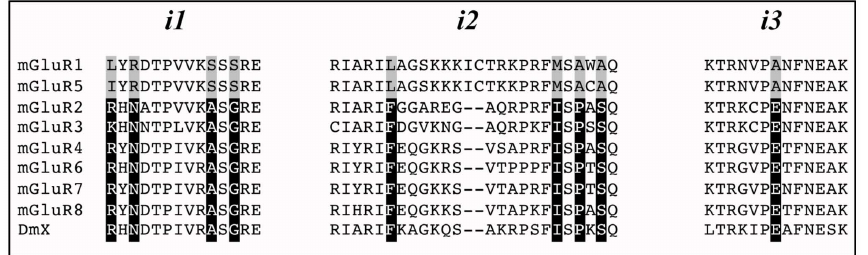
Figure 1. Sequence alignment of the intracellular loops of mGluRs and DmXR. i1 , i2 , and i3 correspond to the first, second, and third intracellular loops of mGluRs and DmXR, respectively. Residues conserved in mGluRs coupled to phospholipase C (mGluR1 and 5) are boxed in grey, and the corresponding residues in most adenylyl cyclase coupled mGluRs (mGluR2, 3, 4, 6, 7 and 8) and DmXR are boxed in black, respectively.